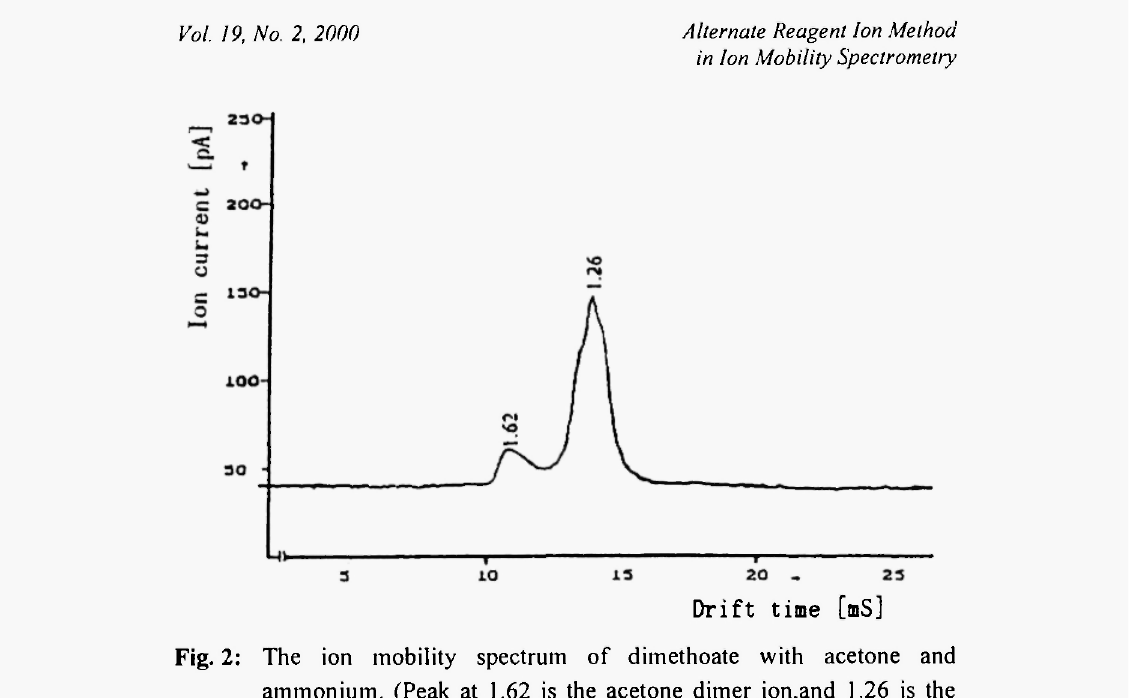
Drift time [mS] Fig. 2: The ion mobility spectrum of dimethoate with acetone and ammonium. (Peak at 1 .62 is the acetone dimer ion,and 1 .26 is the dimer ion of dimethoate.)